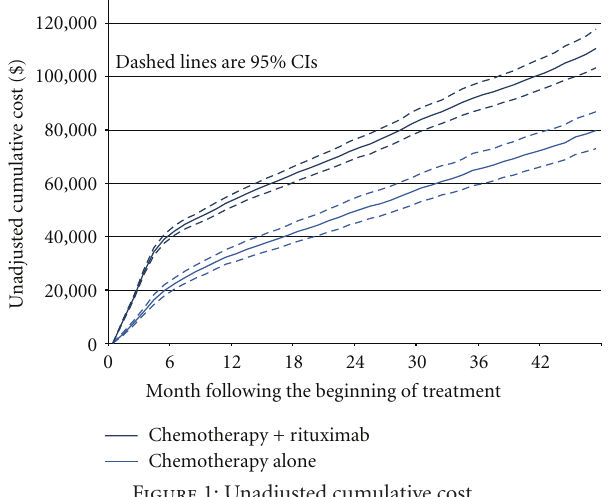
Figure 1: Unadjusted cumulative